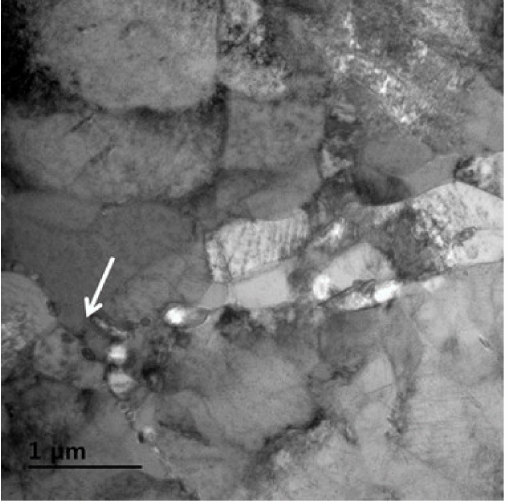
Figure 3. TEM microscopy of STA-treated TNZ40 alloy containing 0.2%